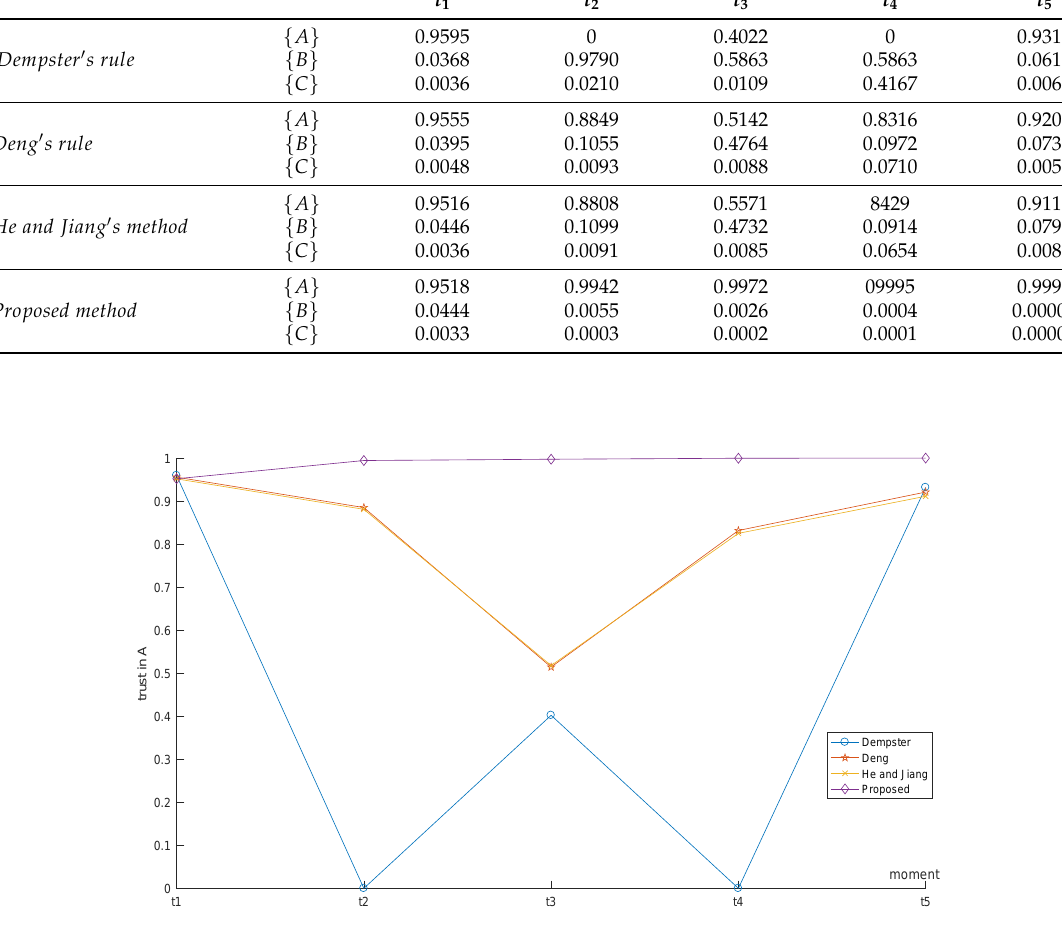
Figure 11. The trend of the results at five moments when the target moves along